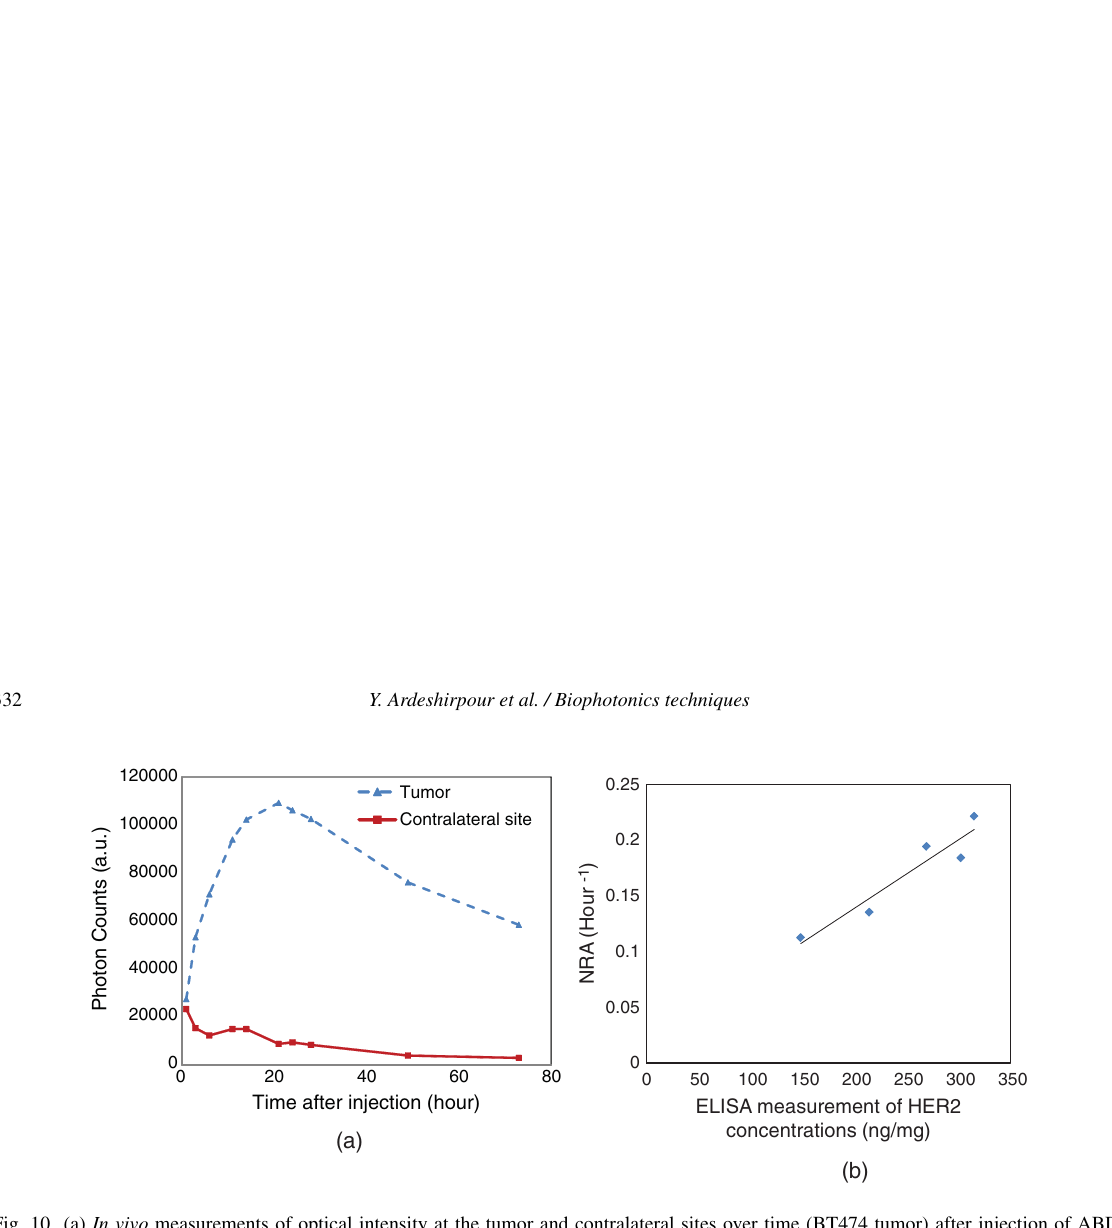
Fig. 10. (a) In vivo measurements of optical intensity at the tumor and contralateral sites over time (BT474 tumor) after injection of ABD- (Z HER2:342 ) 2 Affibody labeled with Alexafluor 750 (b) Estimated NRA of several BT474 tumors with different HER2 expression vs. ex vivo measurement of HER2 concentration obtained by ELISA assay (after